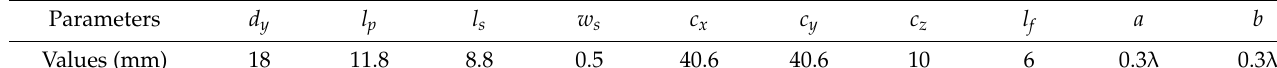
Table 1. The values of the optimal design parameters of the proposed antenna.